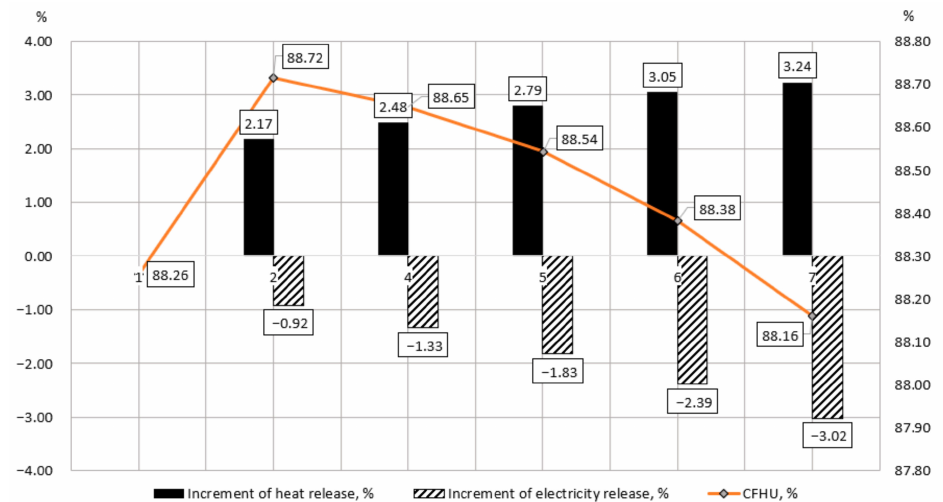
Figure 11. Influence of VCHP on the heat and electricity release.